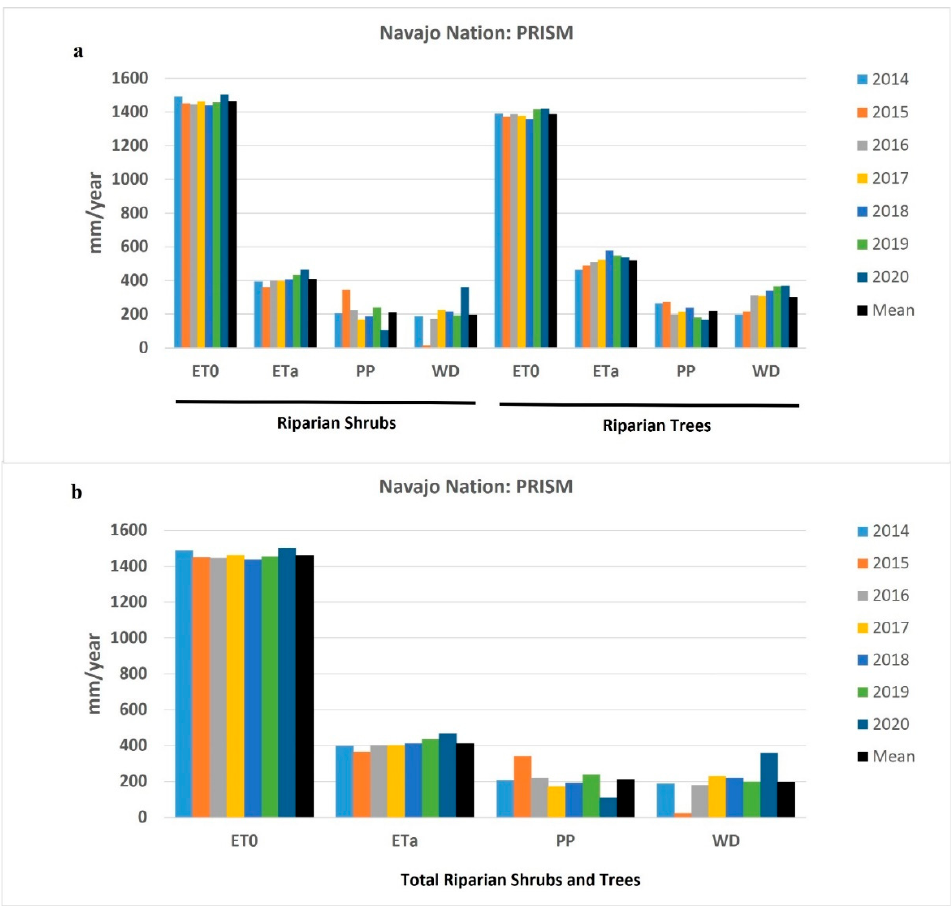
Figure 11. Summary bar plot showing the annual water balance (mm/year) estimated using 30 m resolution Landsat and weather variables from PRISM (gridded, 4 km) for each of the seven individual years (2014–2020), and their long-term average, for potential ET (ETo), actual ET (ETa), precipitation (PP), and the water deficit (WD) with results separated into shrubs and riparian trees (( a ), top) and combined for total riparian vegetation (( b ), bottom).